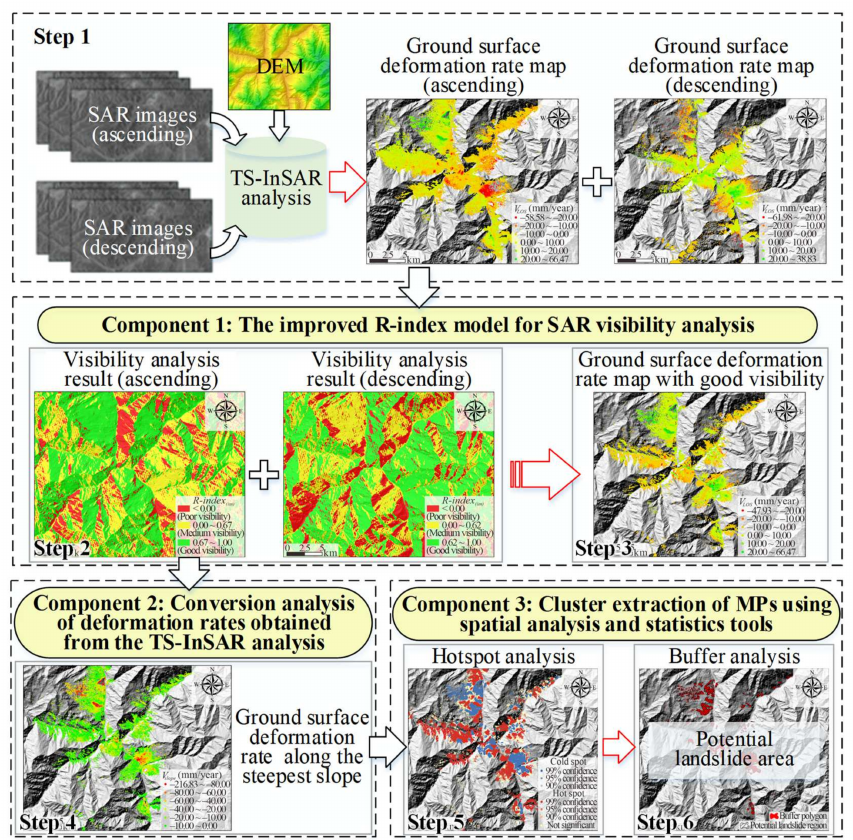
Figure 1. Key components and implementation procedure of the proposed interpretation approach of ascending–descending SAR data for landslide